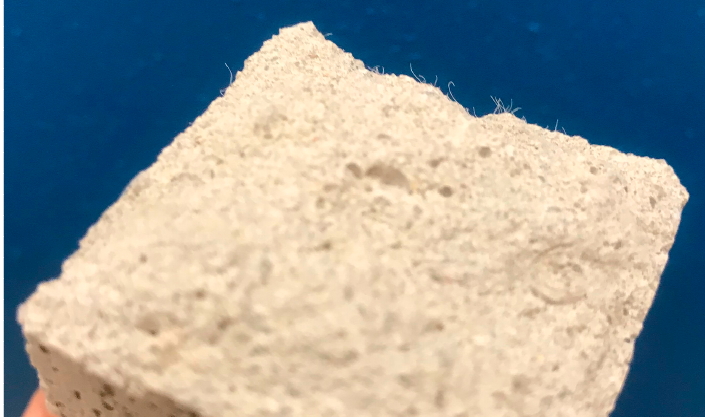
Figure 12. Sample of the modified mortar with wool fiber incorporation .